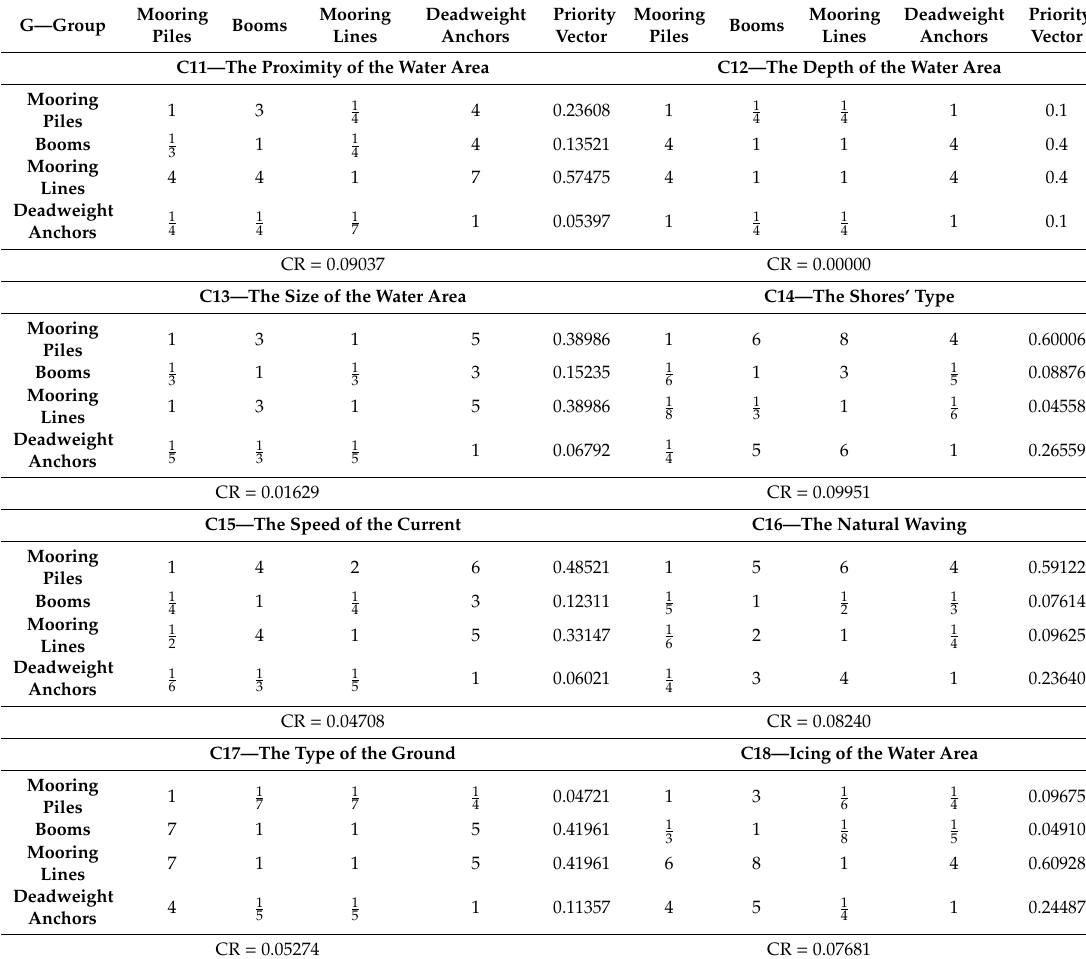
Table 11. Comparison matrix alternative for External risk factors criteria